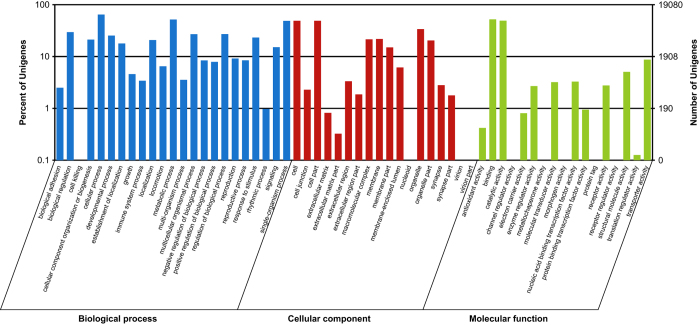
GO classification analysis of unigenes based on biological process, cellular component, and molecular function.